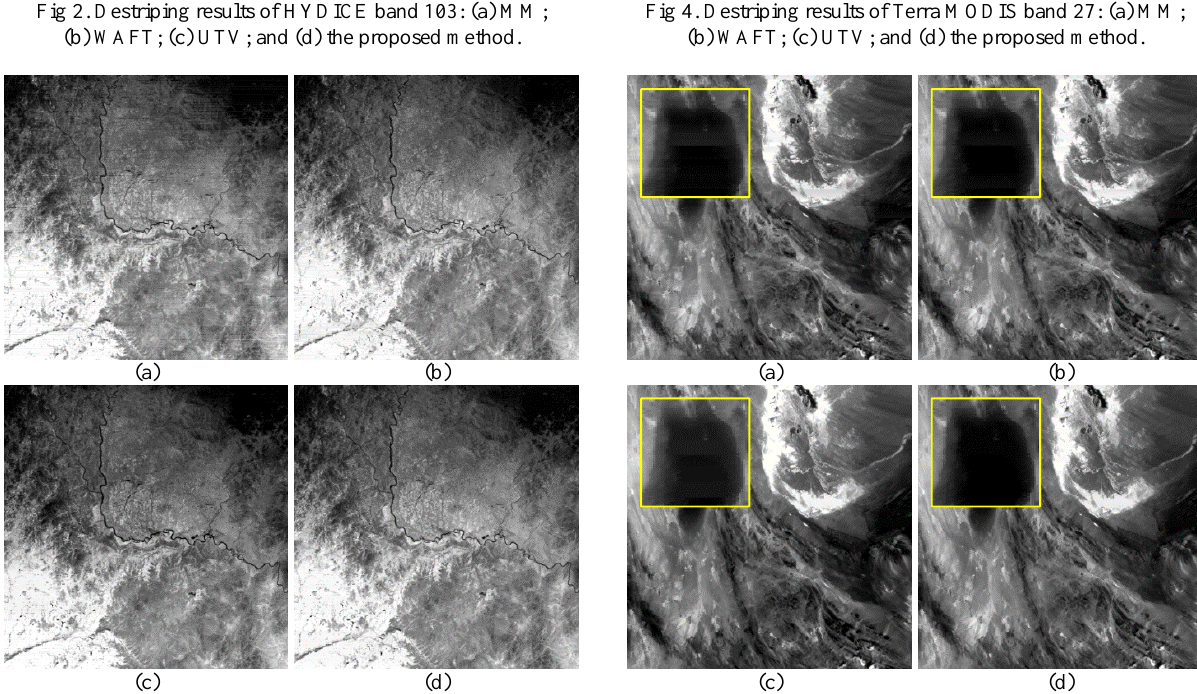
Fig 3. Destriping results of Terra MODIS band 30: (a) MM;